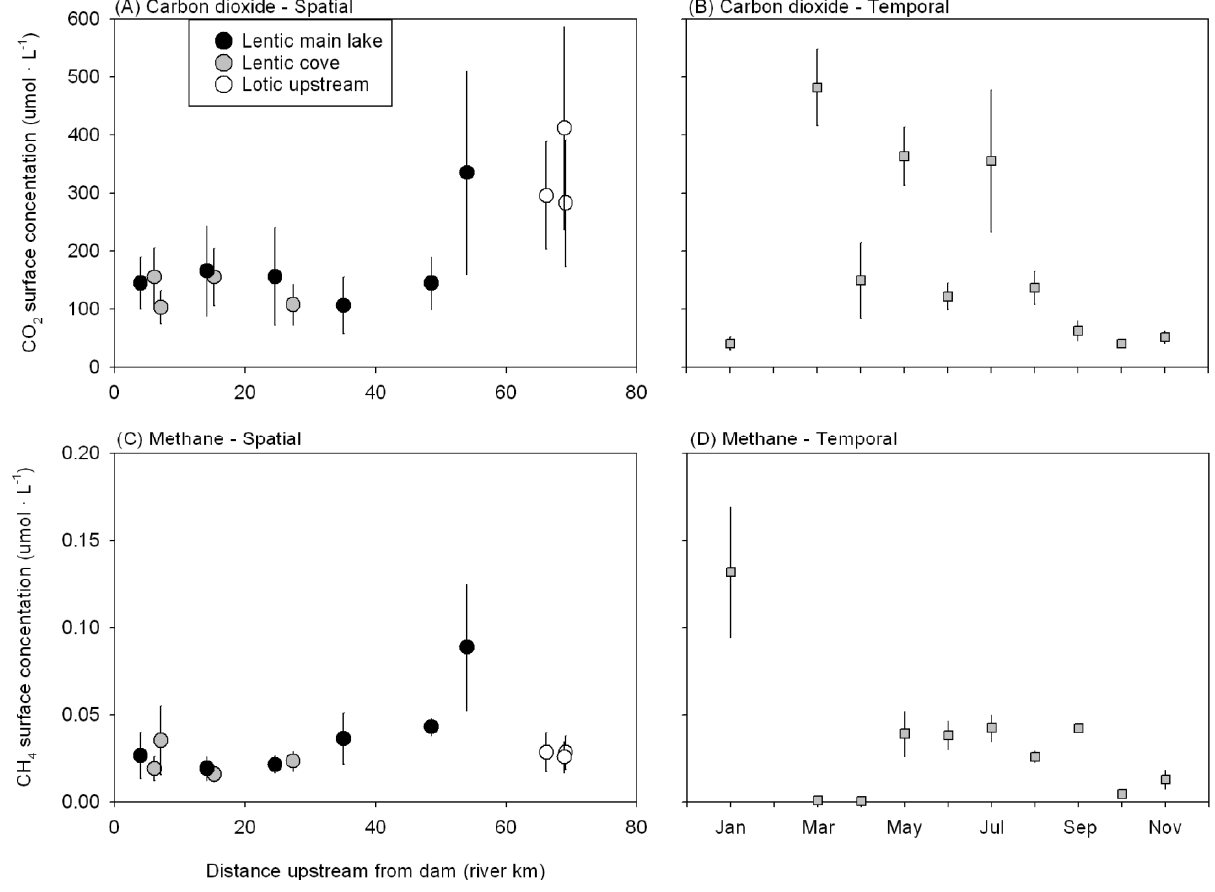
Figure 2. Surface concentrations of ( A , B ) CO 2 and ( C , D ) CH 4 from Douglas Lake as functions of ( A , C ) longitudinal position and ( B , D ) month of the year. Error bars represent 95% confidence intervals around the sample